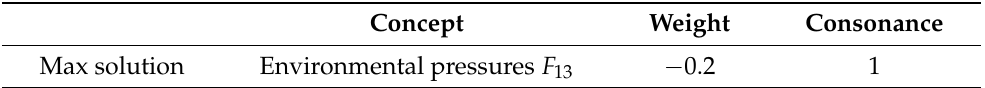
Table 11. Maximum solution for control concepts of the fuzzy cognitive map determining the failure of the project.